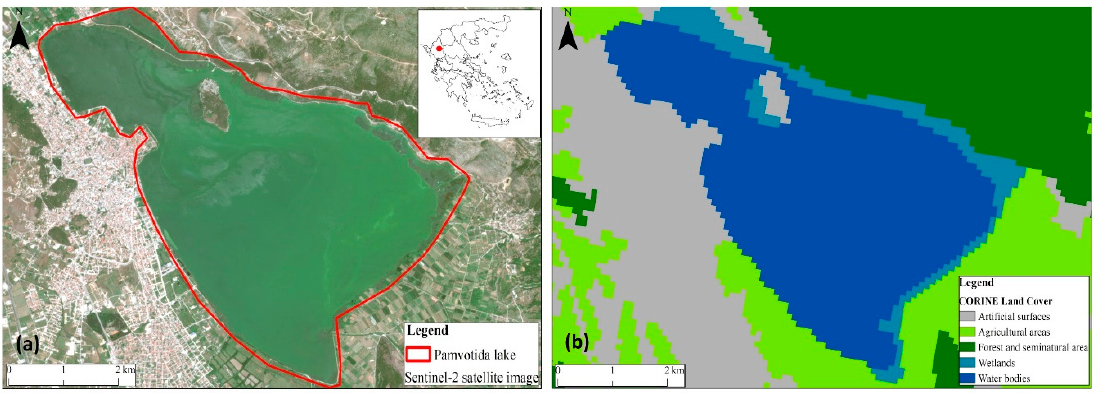
Figure 1. ( a ) The study area of Pamvotis lake, Greece and ( b ) the CORINE land cover